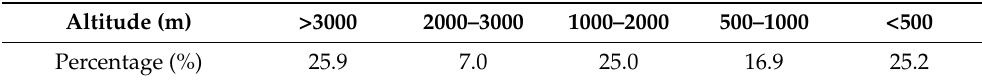
Table 3. Proportions of areas at all altitude levels in